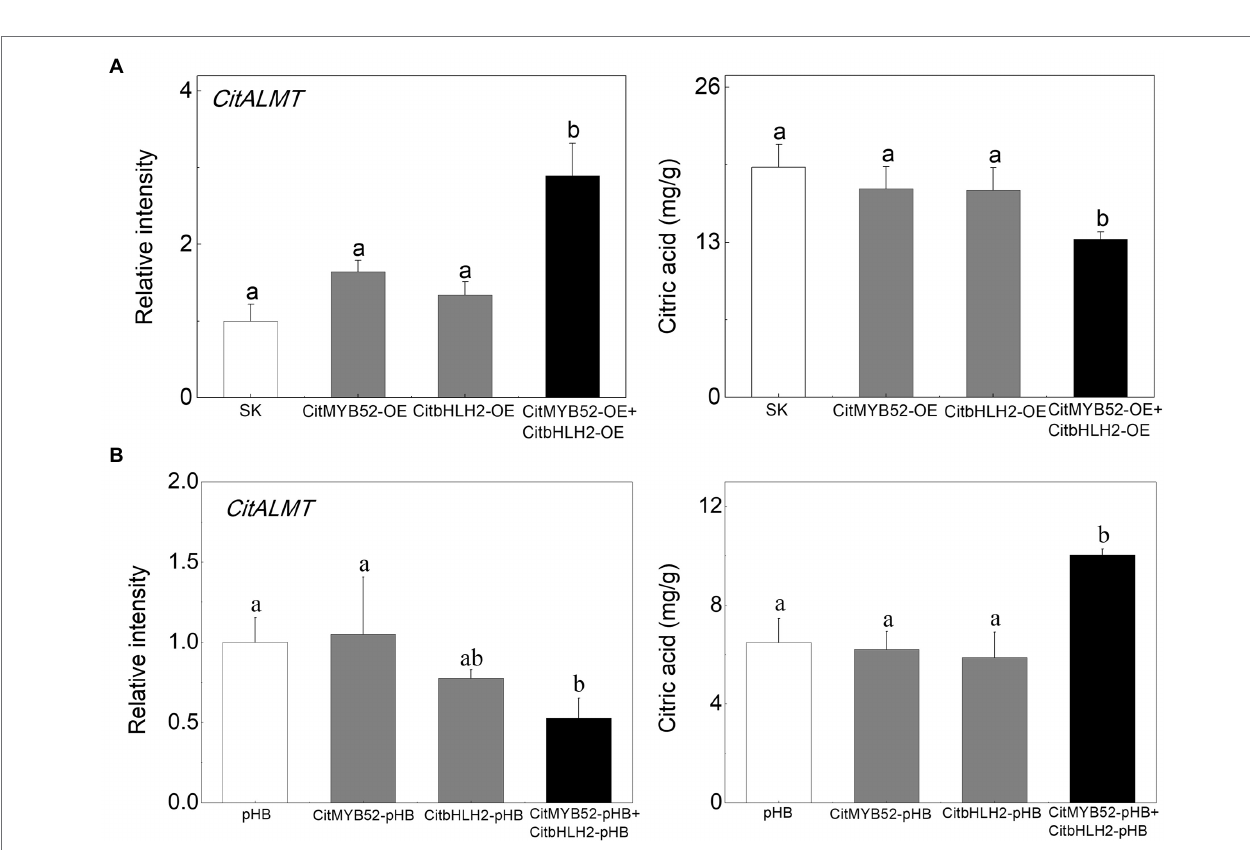
FIGURE 6 | Effects on the citrate concentration of transient overexpression or RNAi inhibition of CitMYB52 and CitbHLH2. The transcript level of CitALMT (left) and citrate concentration (right) were analyzed in citrus fruits. (A) Transient overexpression of CitMYB52 and CitbHLH2 in citrus fruits. SK represents empty vector. (B) Transient RNAi of CitMYB52 and CitbHLH2 in citrus fruits. pHB represents empty vector. Error bars indicate SE from three biological replicates. Different letters above the columns represent significant differences ( p <